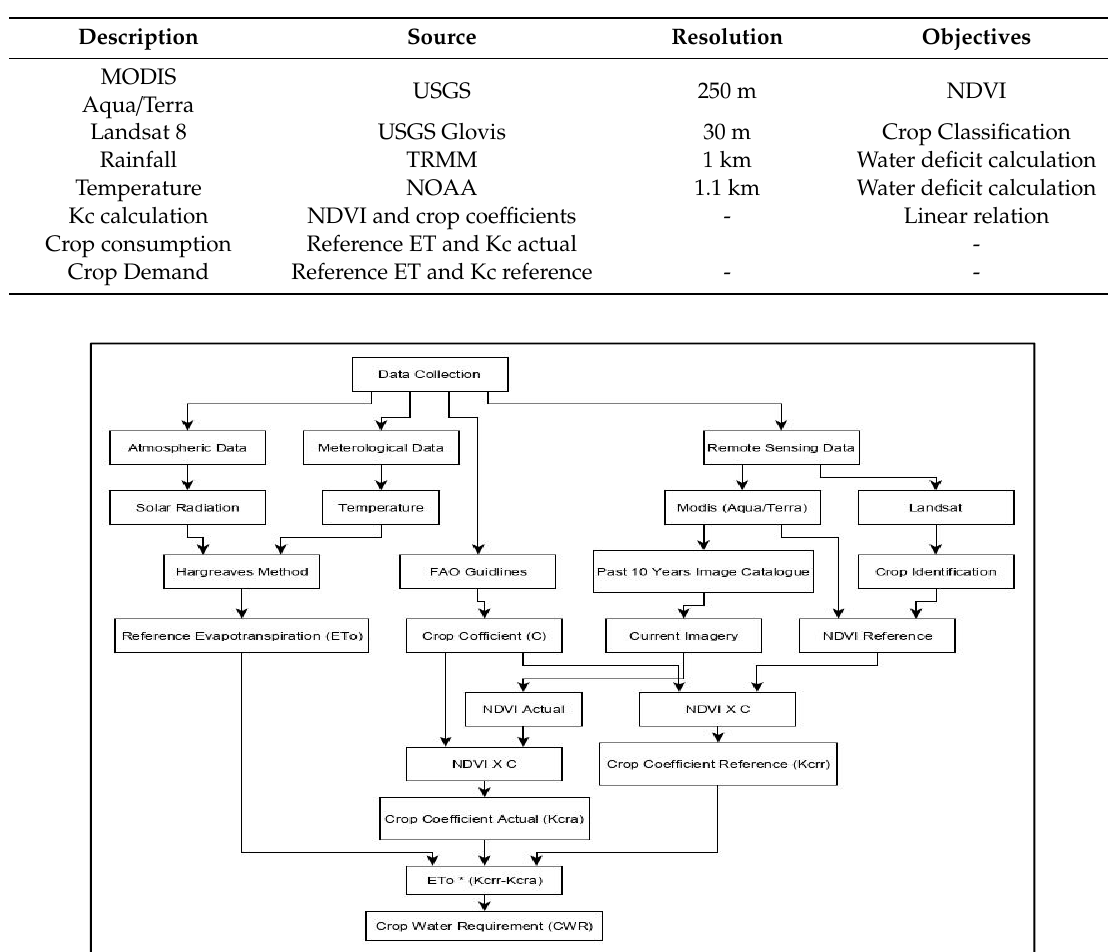
Figure 3. Methodological framework of the study.